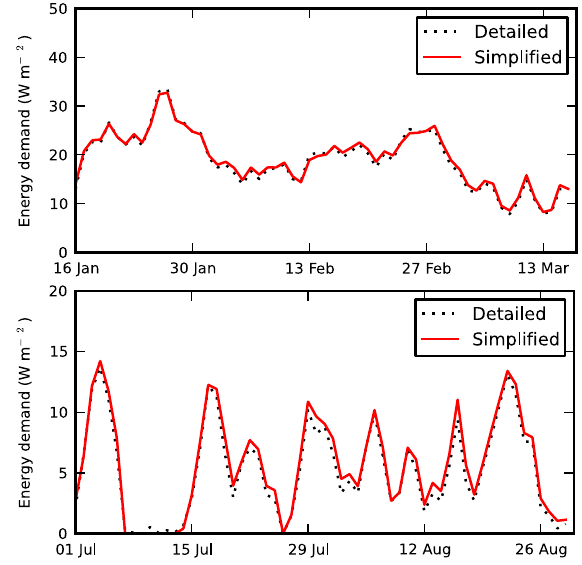
Fig. 4. Daily-average heating (top) and cooling (bottom) energy de- mand per unit of floor area for winter and summer calculated by the simplified and the detailed EnergyPlus models of a Haussmannian building in Paris.